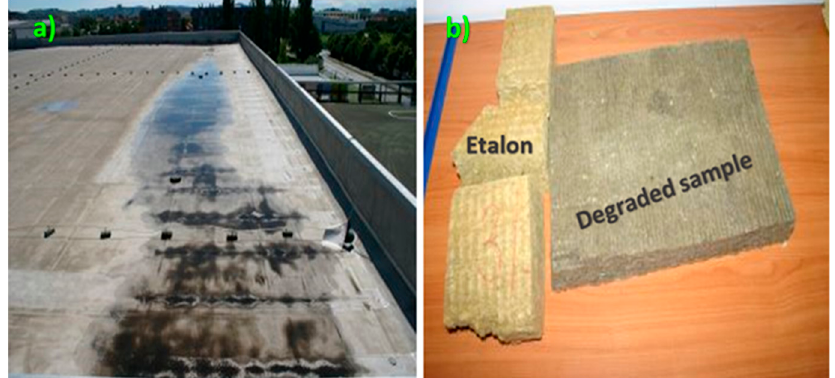
Figure 1. Scheme of the roofing structure.